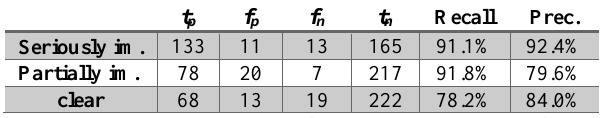
Table 1. Recall and Precision of the impairment analysis